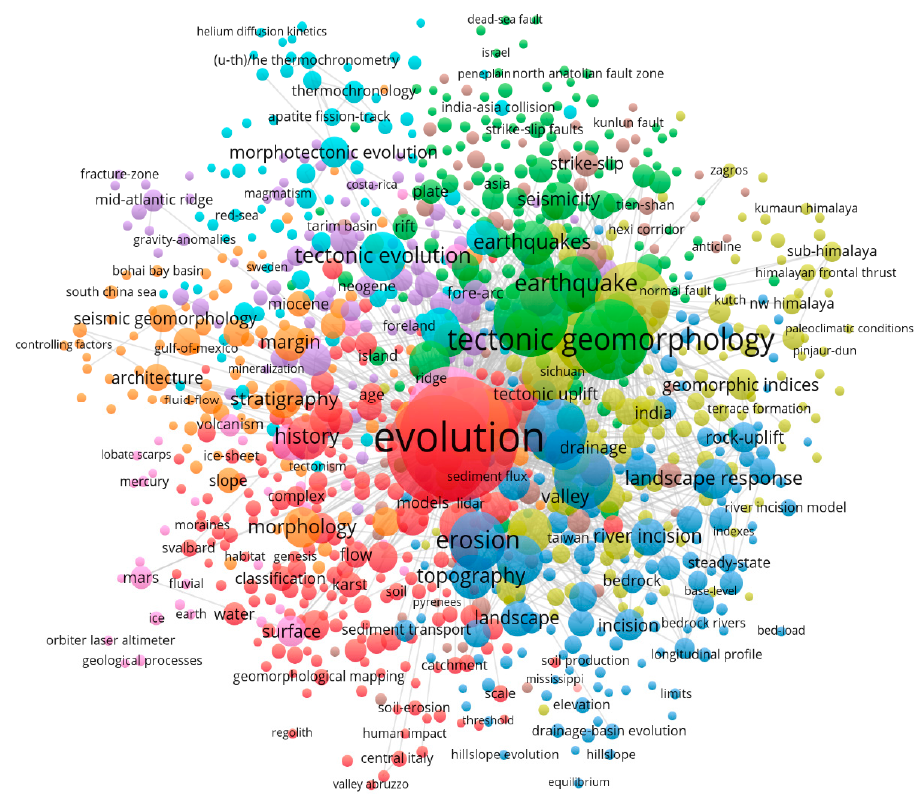
Figure 6. Keywords network on tectonic geomorphology research in 1981–2021.